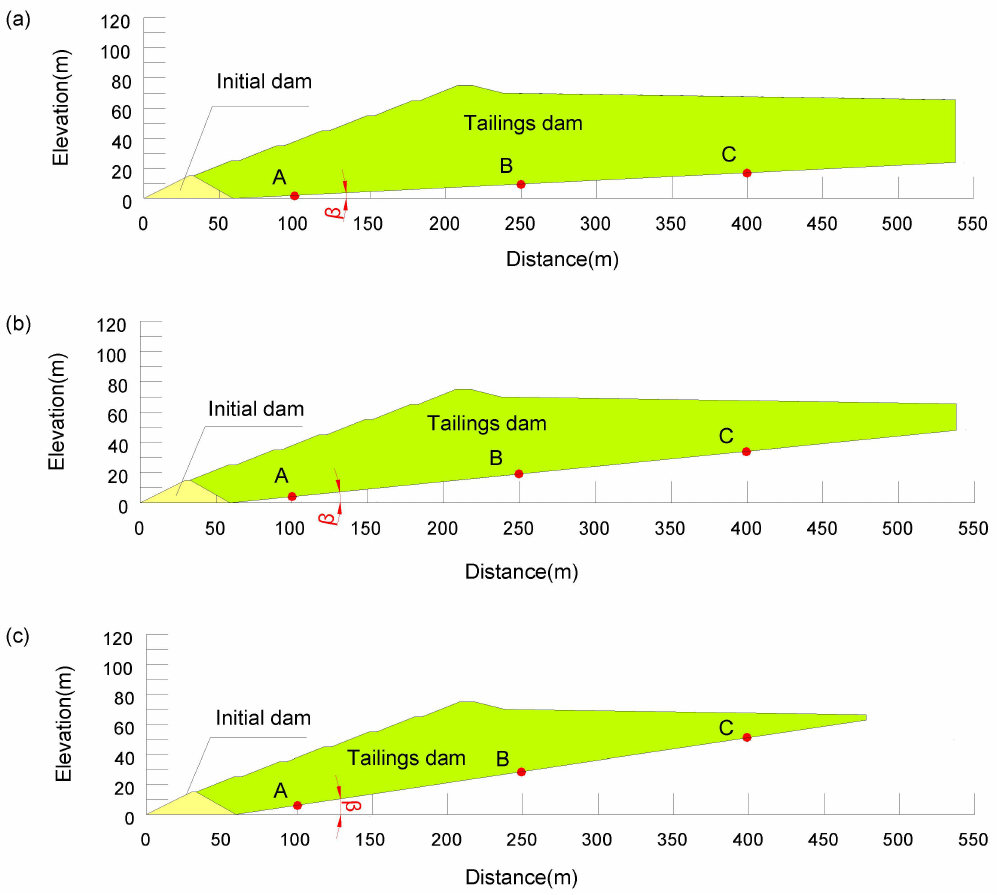
Figure 2. Model of dry-stack tailings pond: ( a ) i = sin β = 0.05; ( b ) i = sin β = 0.1; ( c ) i = sin β =